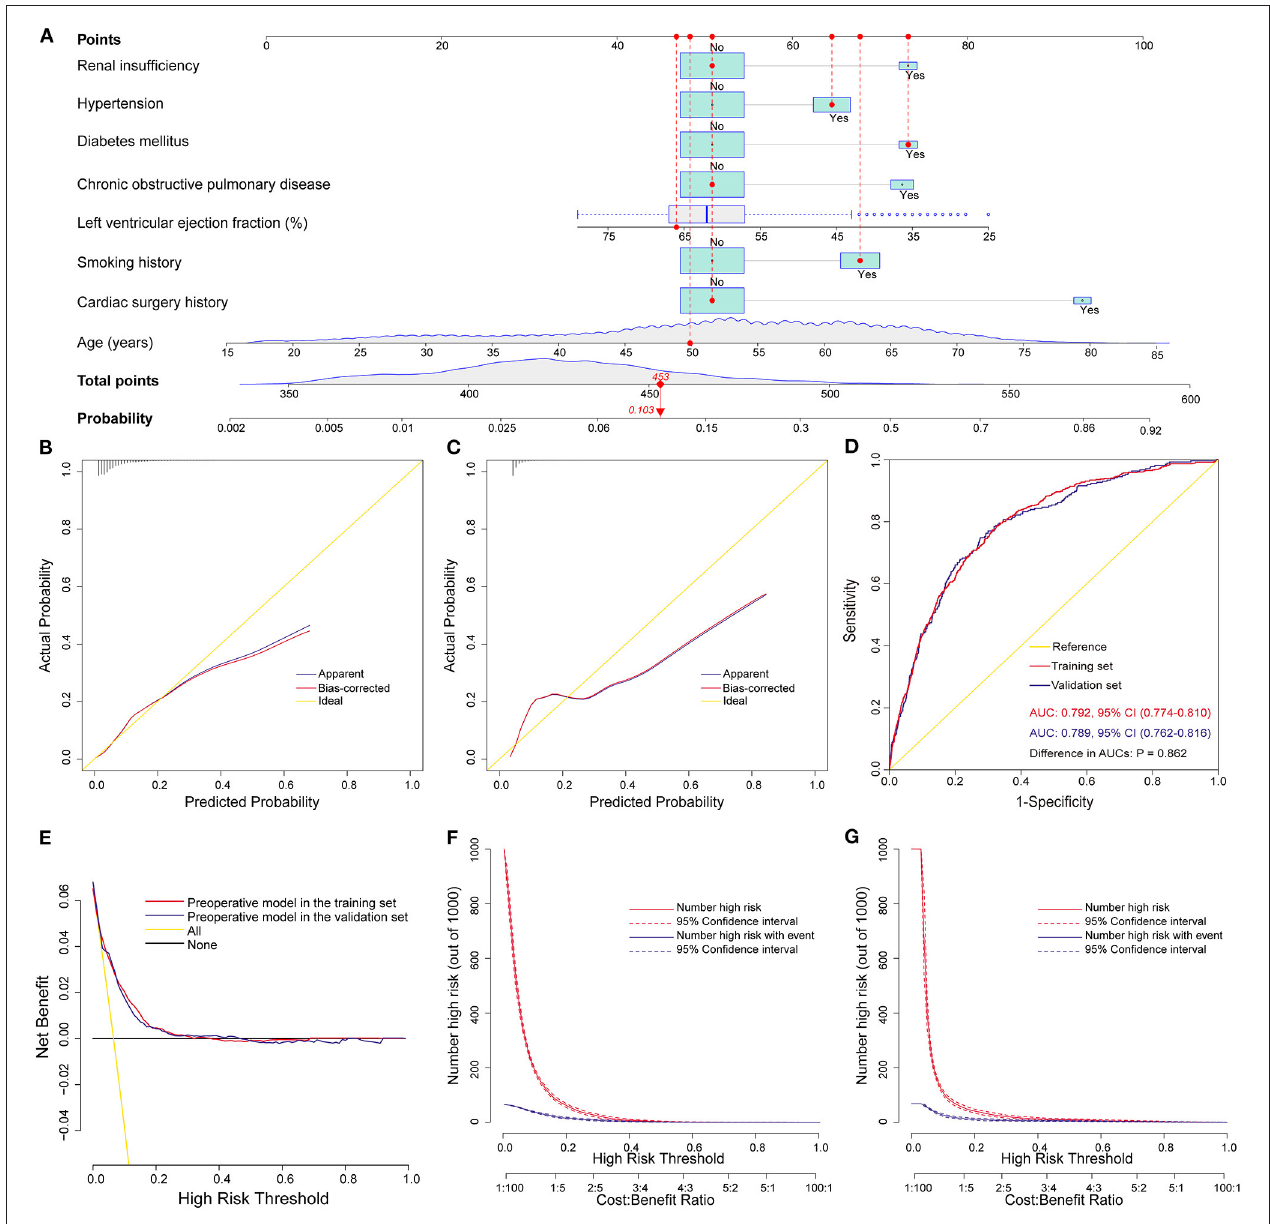
FIGURE 4 | Development, validation, and assessment of the preoperative nomogram model for POP after ECS. Preoperative nomogram for POP after ECS (A) ; A specific patient was shown to illustrate how to use the preoperative nomogram. This was a 50-year-old patient who had a smoking history, hypertension, diabetes mellitus, a left ventricular ejection fraction of 66%, without chronic obstructive pulmonary disease, renal insufficiency and previous cardiac surgery. The individual item score corresponding to each factor was presented at the top, and the total points were obtained from the sum of the scores corresponding to each factor by a red dot. Given values of the 8 predictors, the patient can be intuitively mapped onto the nomogram. It can be clearly seen from the nomogram that the total points of this patient was 453 points and the corresponding probability of POP was 0.103. Calibration plots in the training set (B) and the validation set (C) , ROC curves in the two sets (D) , decision curves in the two sets (E) , and clinical impact curves in the training set (F) and the validation set (G) . AUC, area under the receiver operating characteristic curve; CI, confidence interval; ECS, elective cardiac surgery; POP, postoperative pneumonia; ROC, receiver operating characteristic